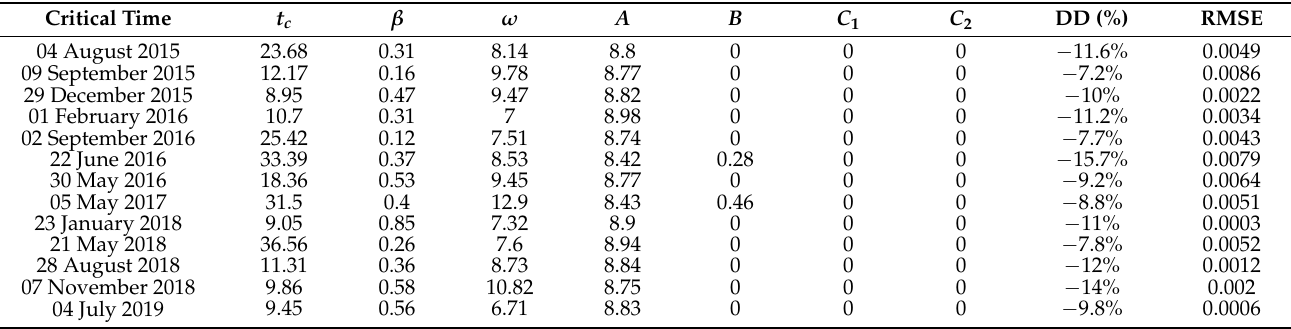
Table 2. Coefficients of the LPPL framework providing a drawdown of >7% in Ireland.